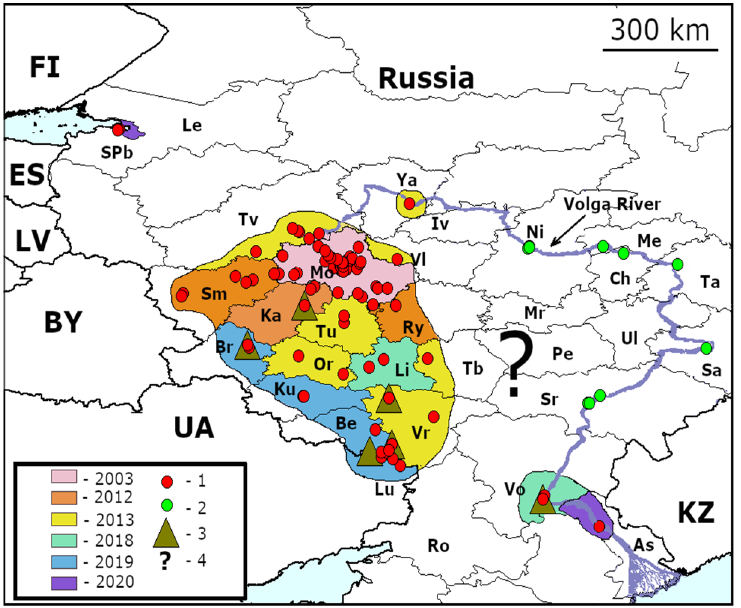
Figure 3. The known range of EAB in European Russia and Ukraine (as of April 2021). Regions of the range are colored according to the year of the first EAB detection in the province as indicated in the legend. 1—localities of EAB detection (Sources of information: [11] and the present study). 2—localities where EAB was not detected in 2020. 3—official quarantine phytosanitary zones declared by National Plant Protection Organization (“Rosselkhoznadzor”) by March 2021 [34]. 4—eastern territories where EAB has not been detected, and no negative data were reported in the